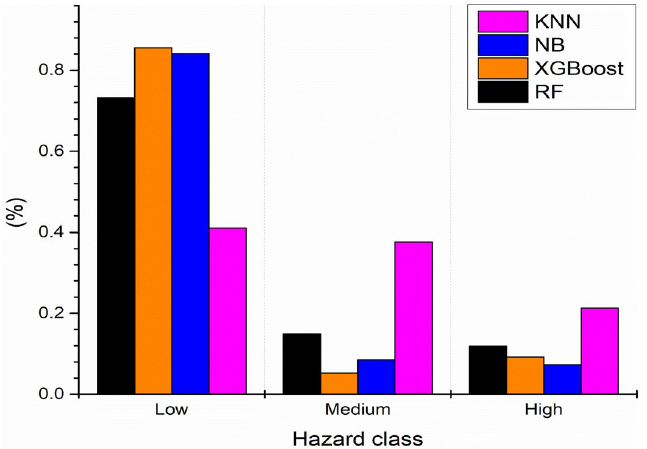
Figure 8. Percentages of the three-earth fissure hazard class (Developed by the first author using graphpad (v.9.2.0) https:// www. graph pad.